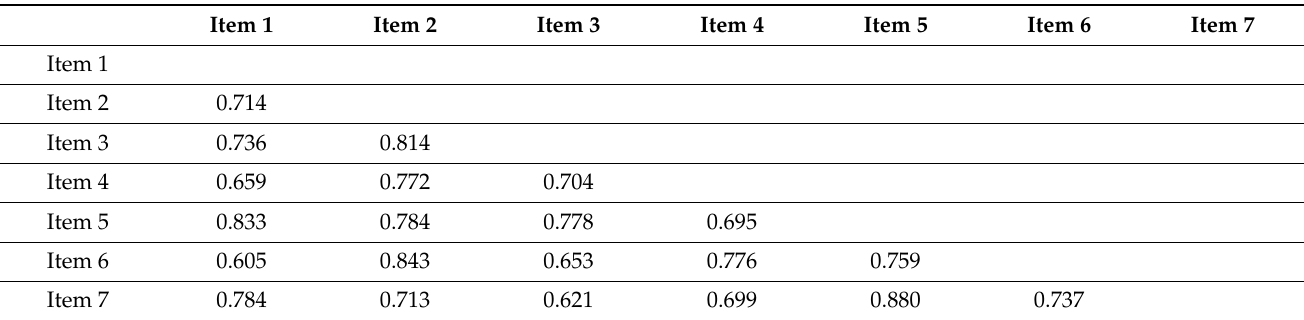
Table 8. WAS inter-item